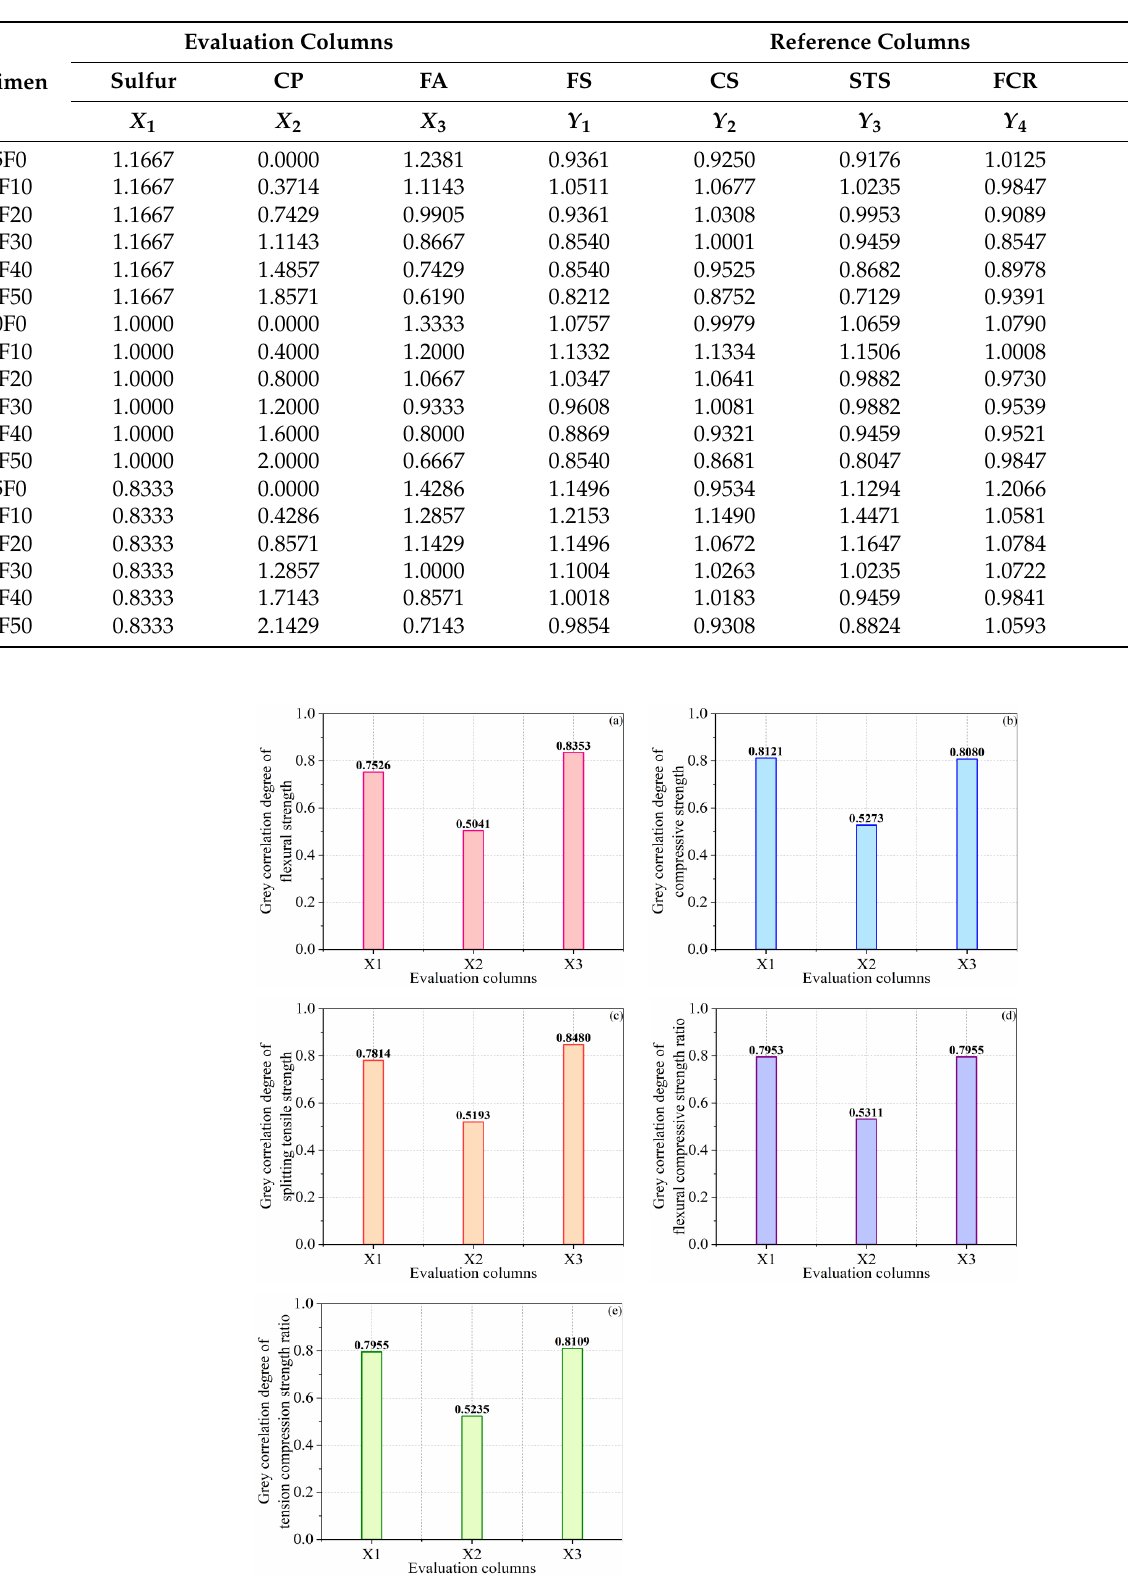
Figure 15. Gray correlation degree between influencing factors and reference indices ( a ) reference indices is FS; ( b ) reference indices is CS ( c ) reference indices is STS; ( d ) reference indices is FCR ( e ) reference indices is TCR.